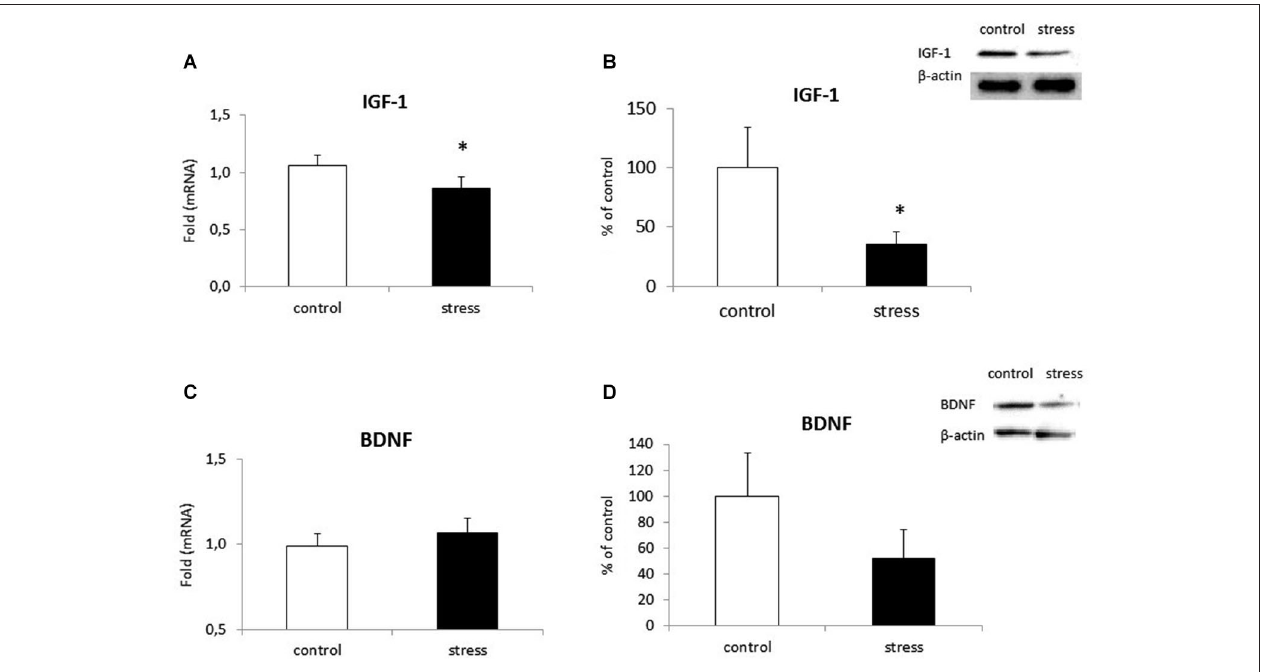
results from western blot analyses are normalized with β -actin and presented as the % of control ± SD from 3 independent experiments ( n = 6 in each group), * p < 0.05; one-way